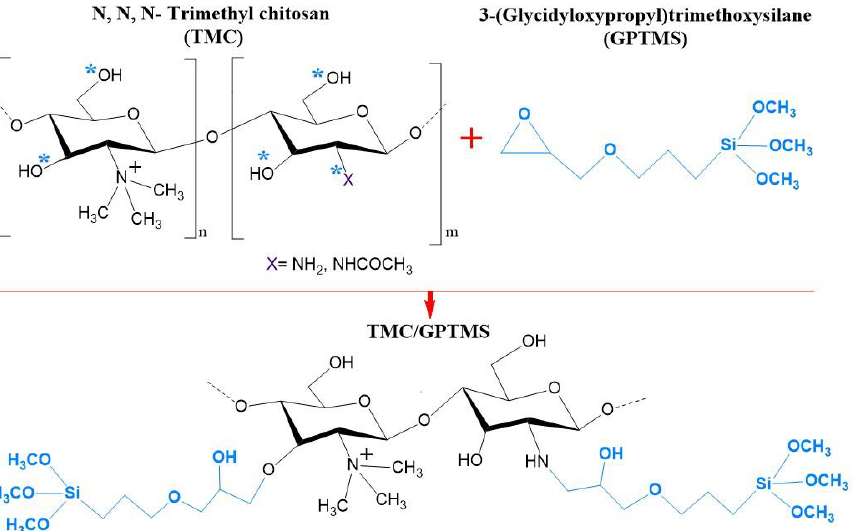
Figure 2. Schematic representation of the reaction between the hydroxyl (−OH) and/or amine (−NH 2 ) groups of N,N,N -trimethyl chitosan (TMC) with the epoxide groups of 3-(glycidyloxypropyl)trimethoxysilane (GPTMS). The reactive target sites are indicated with *.